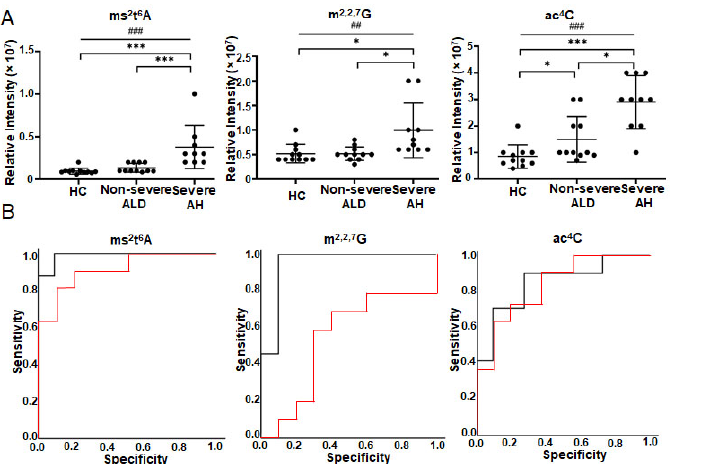
Figure 3. Modified ribonucleoside changes in the serum of the patients with ALD detected by targeted metabolomics using SPE RPC-MS. Nucleosides were extracted from the serum of healthy volunteers ( n = 11) and patients ( n = 23) and detected by SPE LC-MS under positive mode. ( A ) is the abundance changes of modified ribonucleosides in the serum of patients. ( B ) shows ROC analysis results. The red curve shows the ROC analysis results of HC vs. non-severe ALD. The AUC of ms 2 t 6 A is 0.918, p = 0.001 and 95% CI = 0.801–1.000. AUC of m 2,2,7 G is 0.550, p = 0.705 and 95% CI = 0.280–0.820. AUC of ac 4 C is 0.843 p = 0.006 and 95% CI = 0.680–1.000. The black curve shows the